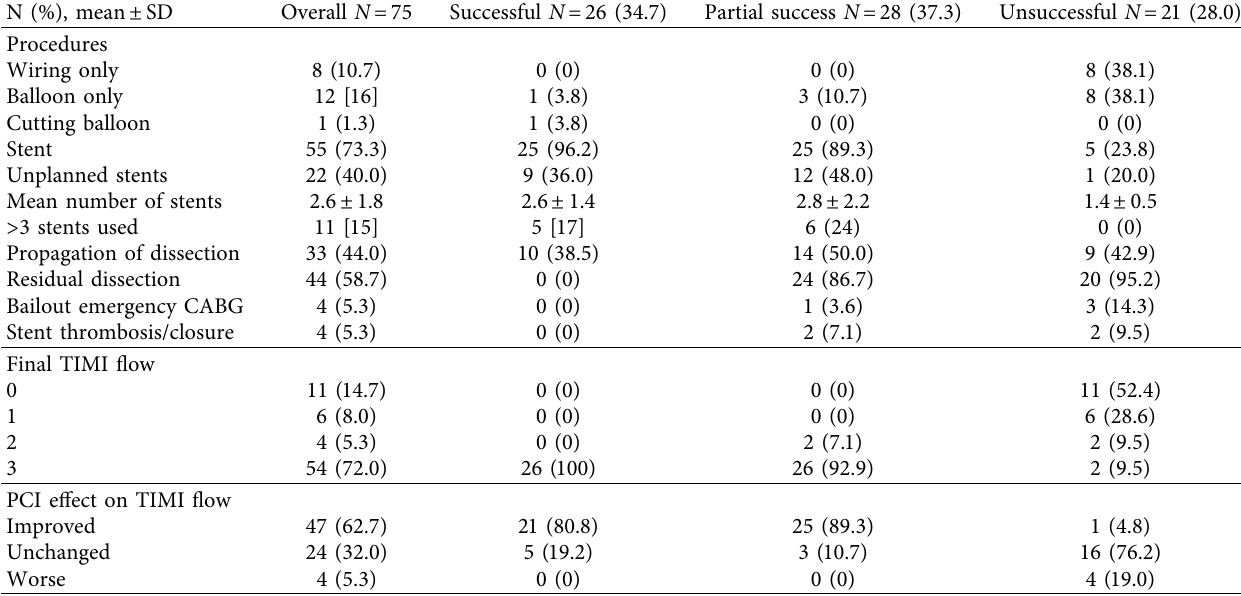
Table 4: PCI procedural details and outcomes.